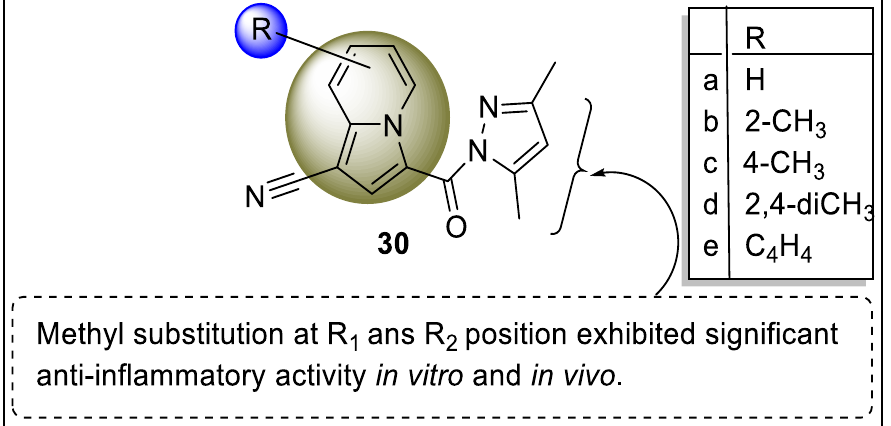
Figure 34. Structural activity relationship of indol hybrids ( 30 ) as potent PPAR ligands.